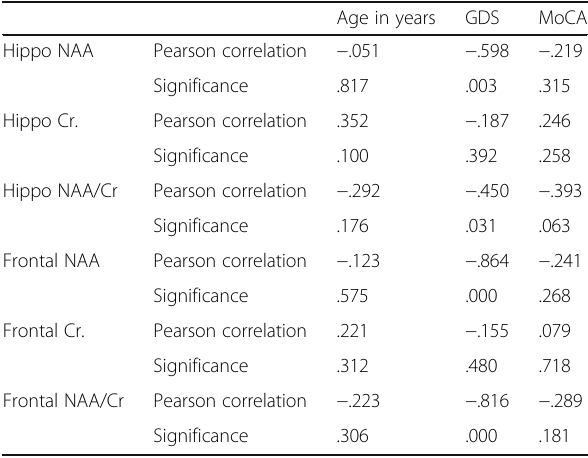
Table 3 Correlations between age, clinical, and spectroscopic data in patients with cognitive impairment associated with depression